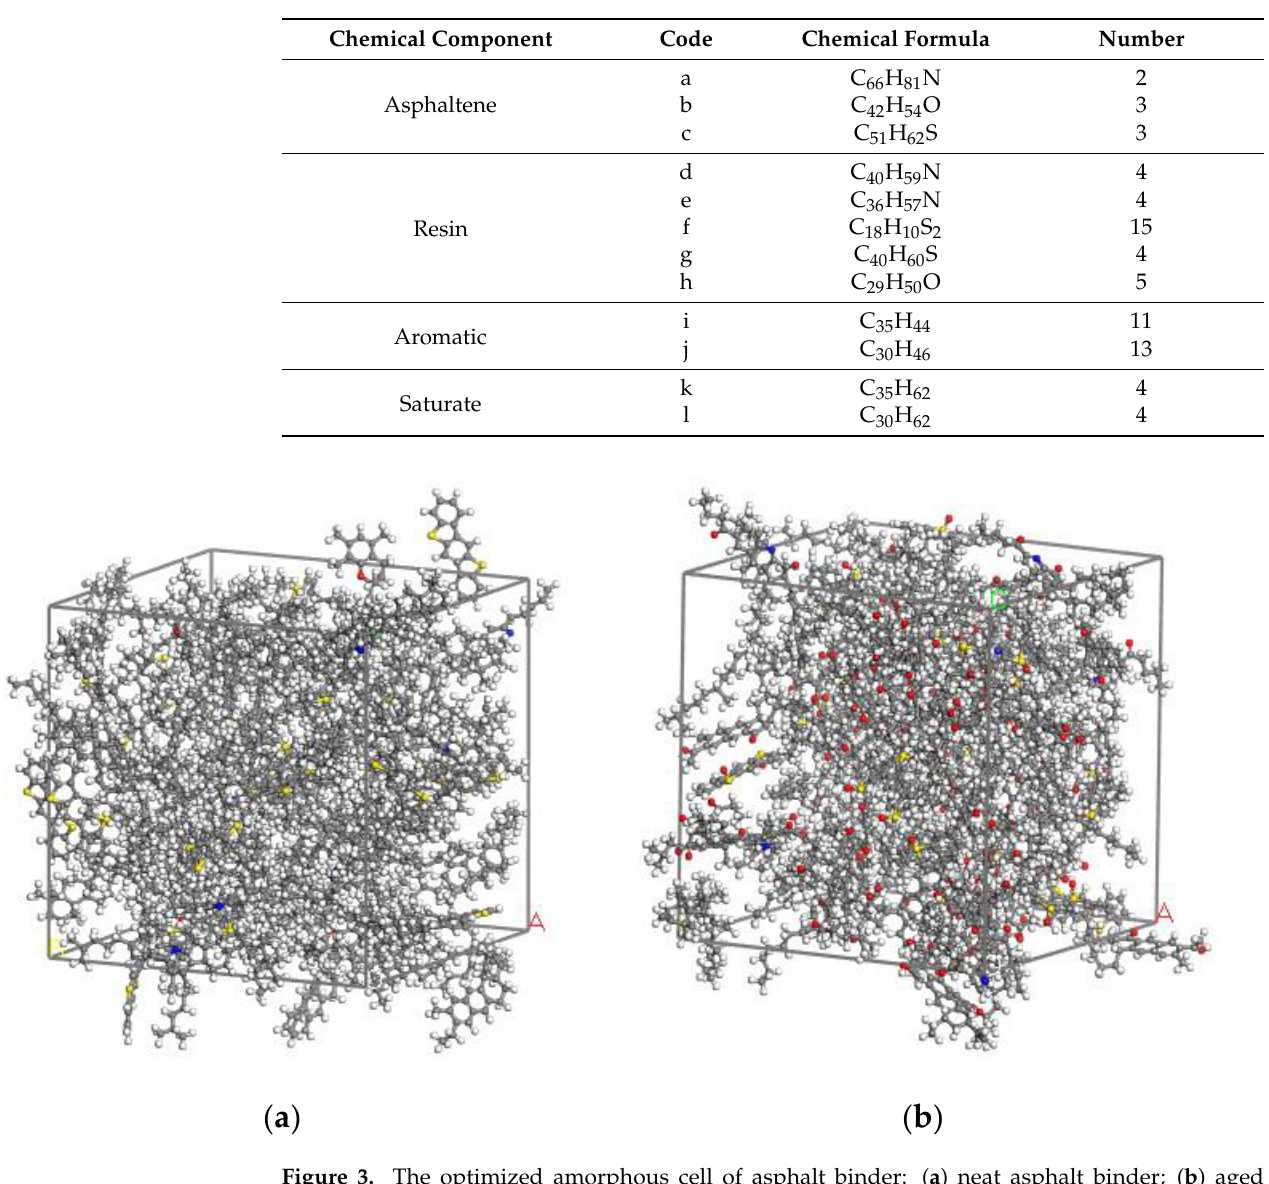
Figure 2. Representative molecules of the four components in aged asphalt binder: ( a – c ) aged as- phaltene; ( d – h ) aged resin; ( i – j ) aged aromatic; ( k – l ) aged saturate. Table 1. Chemical components in the amorphous cell of asphalt binder.